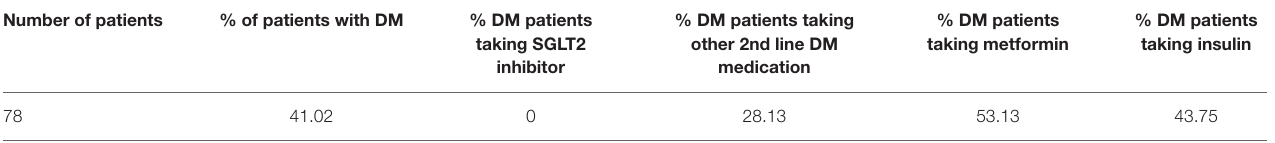
TABLE 4 | Showing the percentages of patients with DM taking an SGLT2 inhibitor and the percentage of patients taking other 2nd line therapy for control of their diabetes. Number of